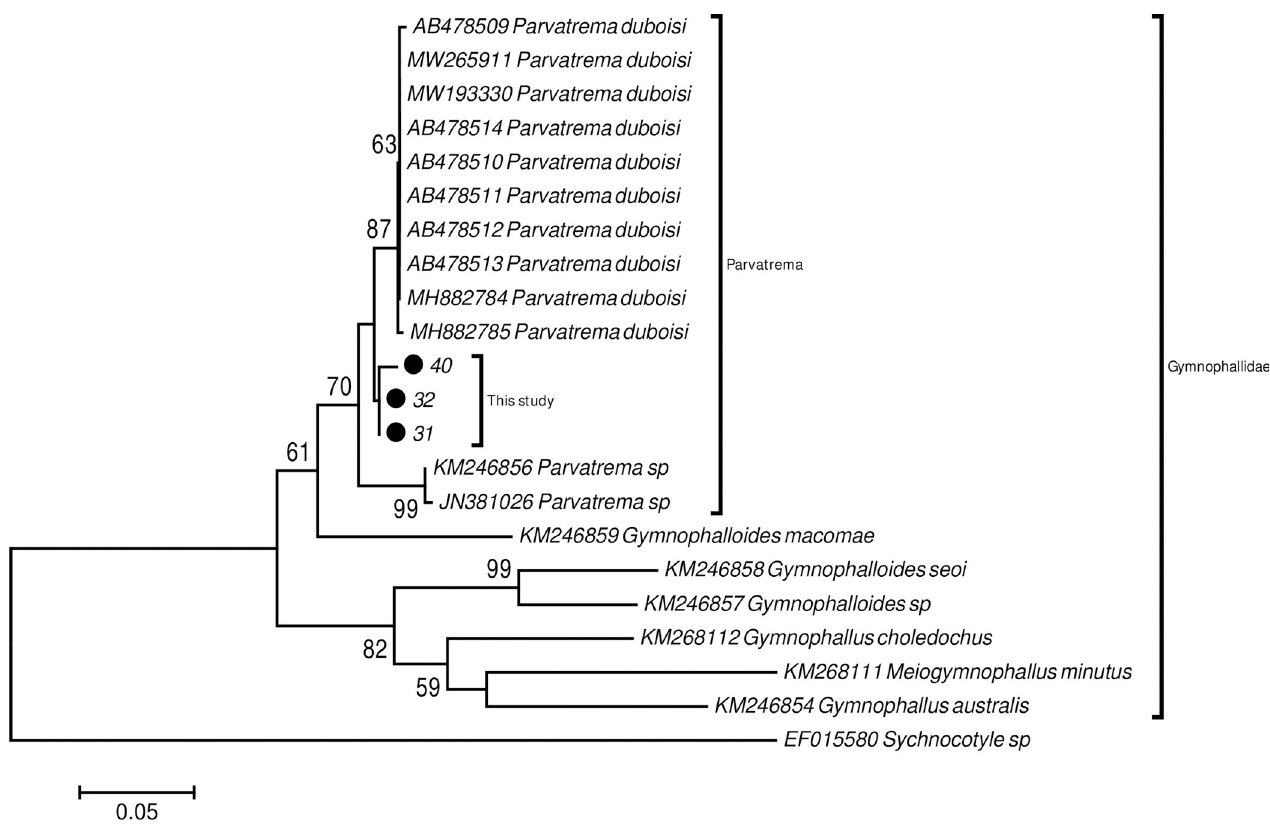
Fig 5. Phylogenetic reconstruction by NJ based on the ITS-2 region, for parasites collected from A . antiqua . The numbers along the branches indicate the percentages of the bootstrap support values resulting from the analyses of NJ. Codes indicate accession numbers for samples obtained from the GenBank.